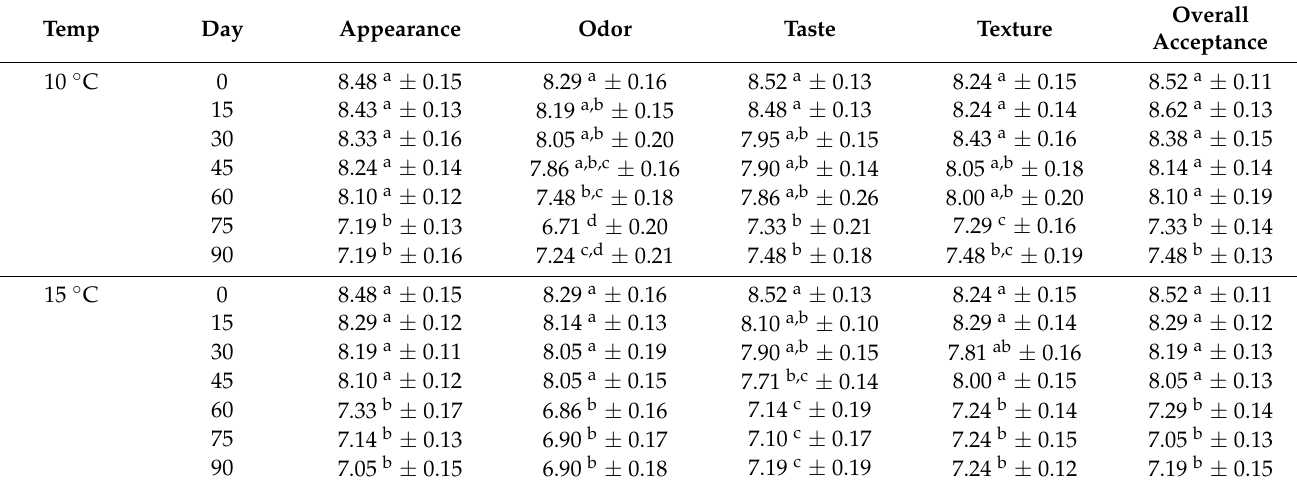
Values are mean ± SE. Different letters (a–d) in each column indicate significant differences among means by Tukey’s test ( p <